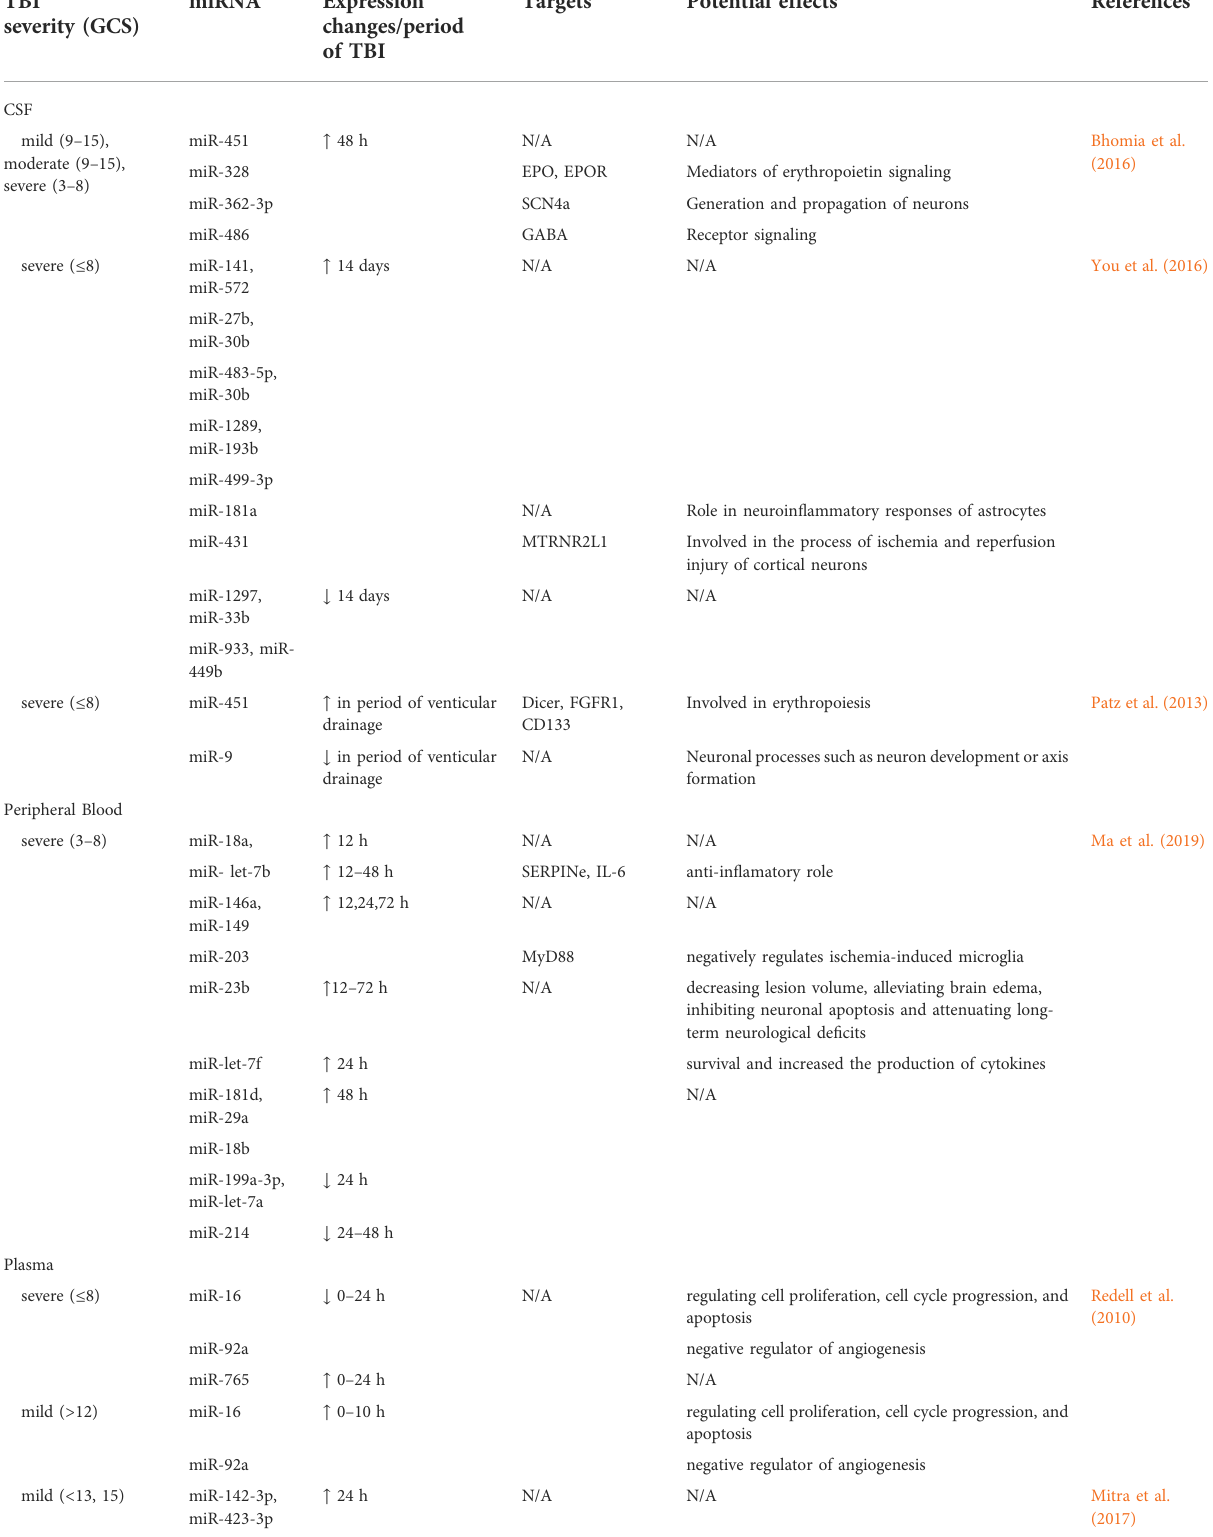
TABLE 2 MiRNA biomarkers TBI in different biological sources from